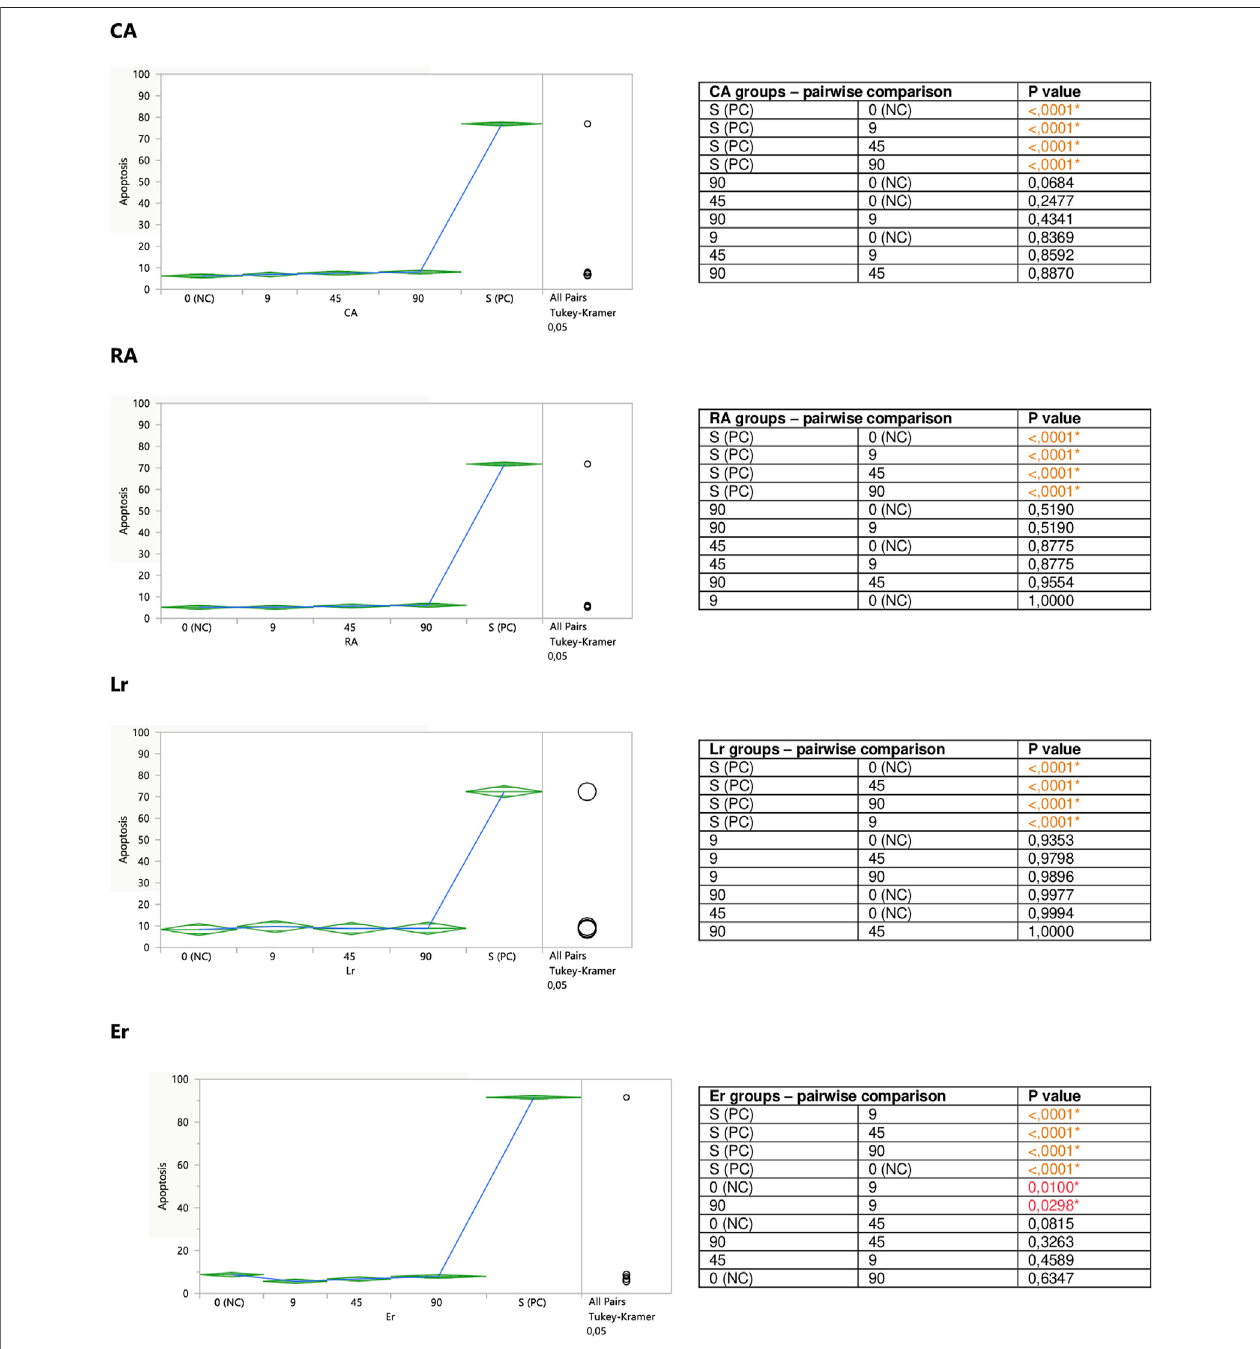
FIGURE 5 | Direct effect of CA, RA, Lr, and Er on apoptosis of Jurkat cells. 0 (NC) = negative control (untreated Jurkat cells); S (PC) = positive control (Jurkat cells treated with staurosporine); 9, 45, 90 = Jurkat cells incubated with a given (poly)phenol at the concentration of 9, 45, or 90 µM. Apoptosis = percent of apoptotic cells. MeansdiamondsillustrateANOVAanalysis(upperandbottompointsareat95%con fi dencepointsofeachgroup).Thecirclesontherightexpresssigni fi cantdifferences between group means (if they do not overlap), or the lack of signi fi cant differences (if they overlap).